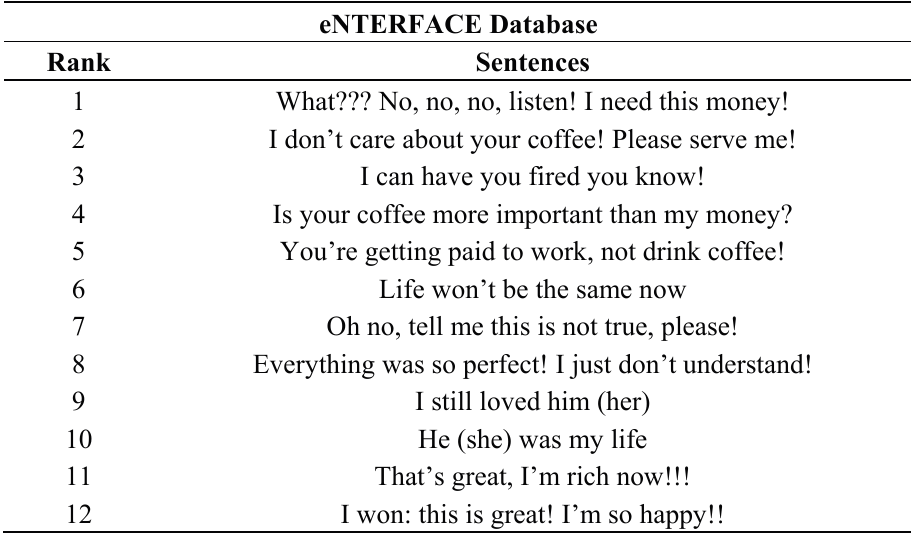
Table 3. The emotional sentences for